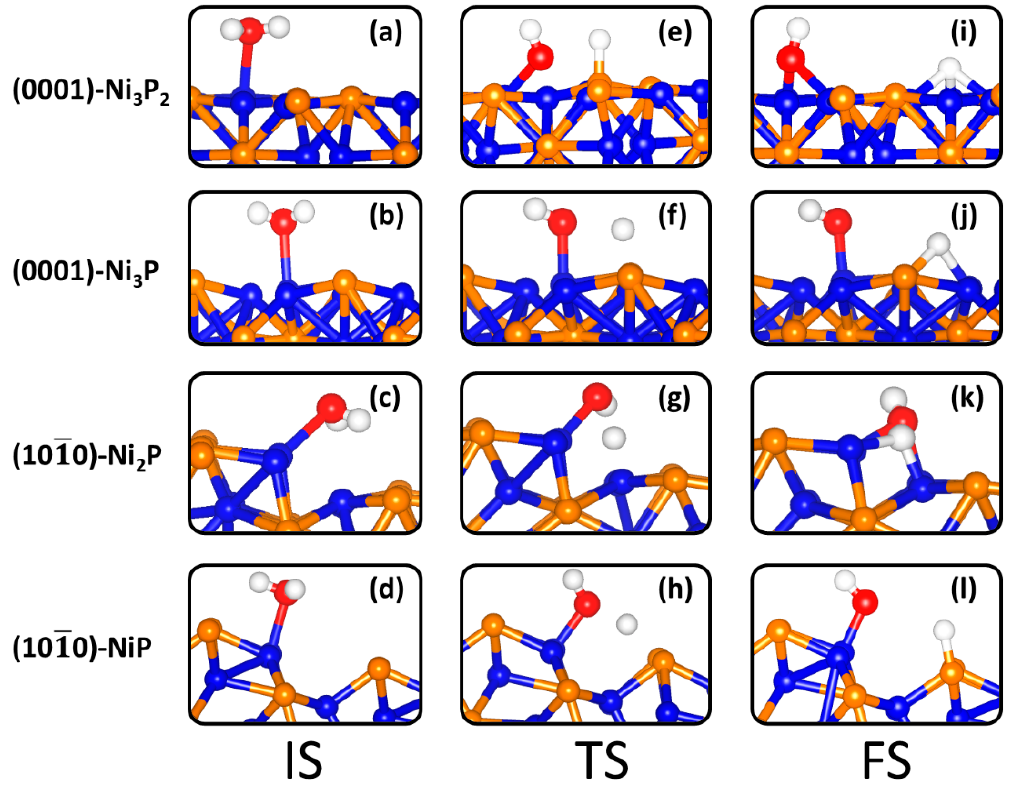
Table 2 . Dissociative adsorption energies (E ads ) and bond lengths (d) for water on Ni 2 P (0001) and (10 1(cid:3364) 0) surfaces. H-P bond distances are denoted as d(P)